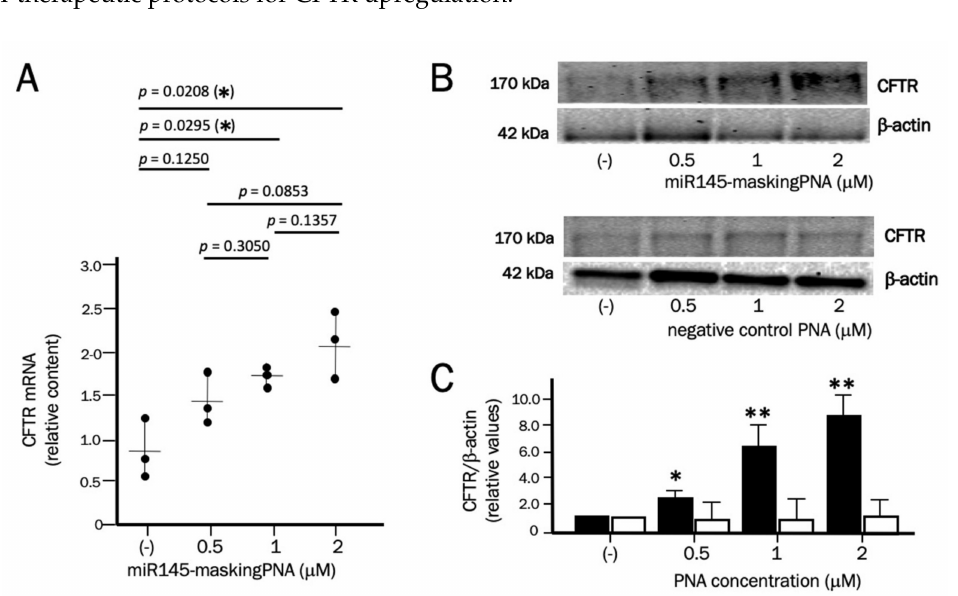
Figure 4. E ff ects of the miR145-maskingPNA on CFTR mRNA ( A ) and CFTR protein ( B , C ) in Calu-3 cells. Calu-3 cells were treated with the indicated concentrations of the miR145-maskingPNA for 3 days. Then, RNA was extracted and CFTR mRNA content determined by RT-qPCR ( A ). At the same time, CFTR was quantified by Western blotting ( C , black bars). In parallel, Calu-3 cells were treated with a negative control PNA for 3 days and Western blotting was performed ( C , white bars). In panel B, representative Western blotting results are shown. In panel C, averages ± SD are shown ( n = 3) with respect to untreated Calu-3 cells. * = p < 0.05; ** = p < 0.01 (miR145-maskingPNA vs. negative control